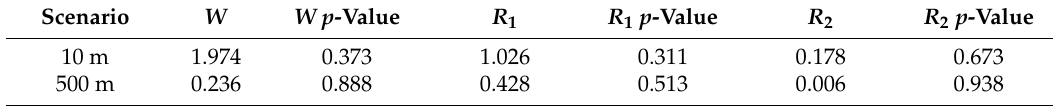
Table 2. Comparisons of the azimuth distributions between recovered and not recovered bay laurels.